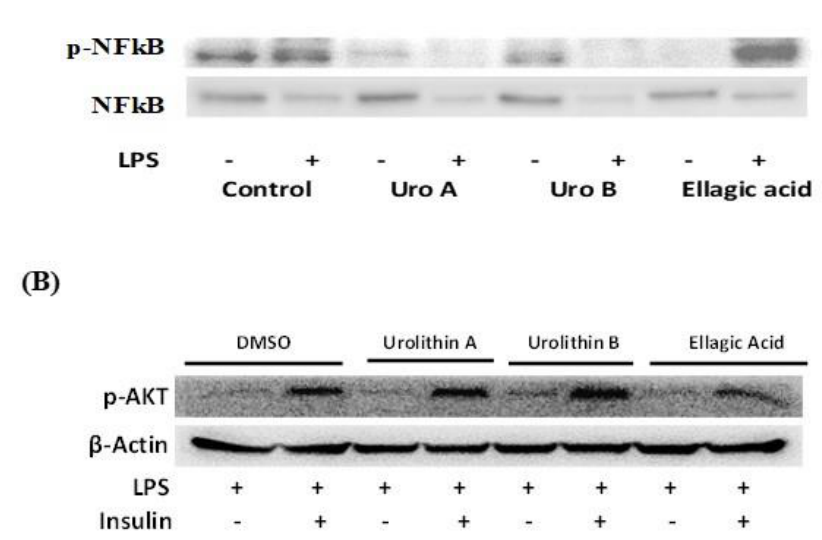
Figure 7. Ellagic acid and urolithins A and B effects on protein expression of transcription factors nuclear factor κB (NF-κB) and protein kinase B (AKT) associated with inflammation and insulin sensitivity in 3T3-L1 adipocytes at day 8 treated with compounds for 24 h and then exposed for 1 h to lipopolysaccharide (LPS; 100ng/mL). Western blot assays for nuclear phosphorylated nuclear factor κB (p-NF-κB; nuclear extract) and cytosolic NF-κB (cytosolic extract) at 25 µM treated adipocytes challenged with or without LPS ( A ) and nuclear phosphorylated AKT (p-AKT; nuclear extract) under LPS-induced inflammation in mature adipocytes with or without insulin (10 µg/mL) ( B ), as described in the Materials and Methods section.